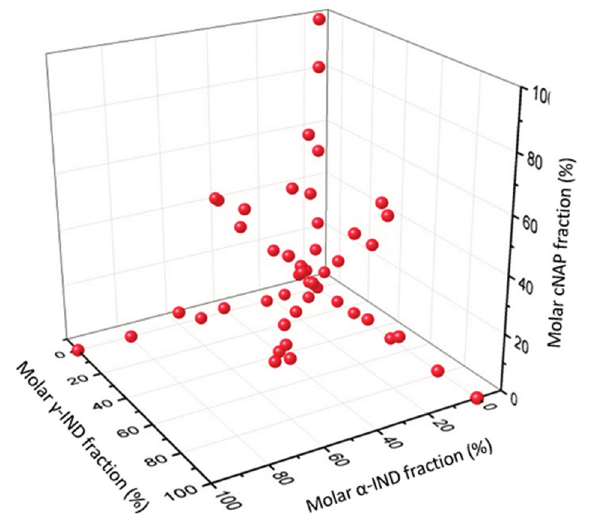
Figure 8. Overview of the phase compositions of the prepared calibration samples containing binary, ternary and quaternary blends of cNAP, γ -IND, α -IND and aNAP/IND 1:1